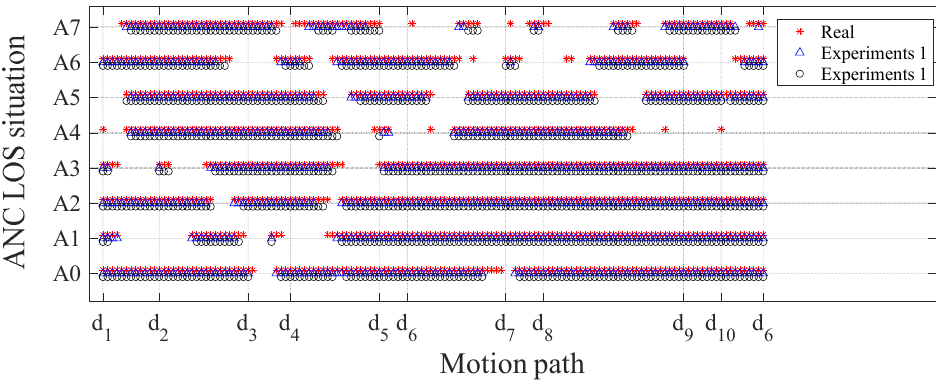
Figure 21. Comparison analysis of LOS selection of each anchor under different experiments.